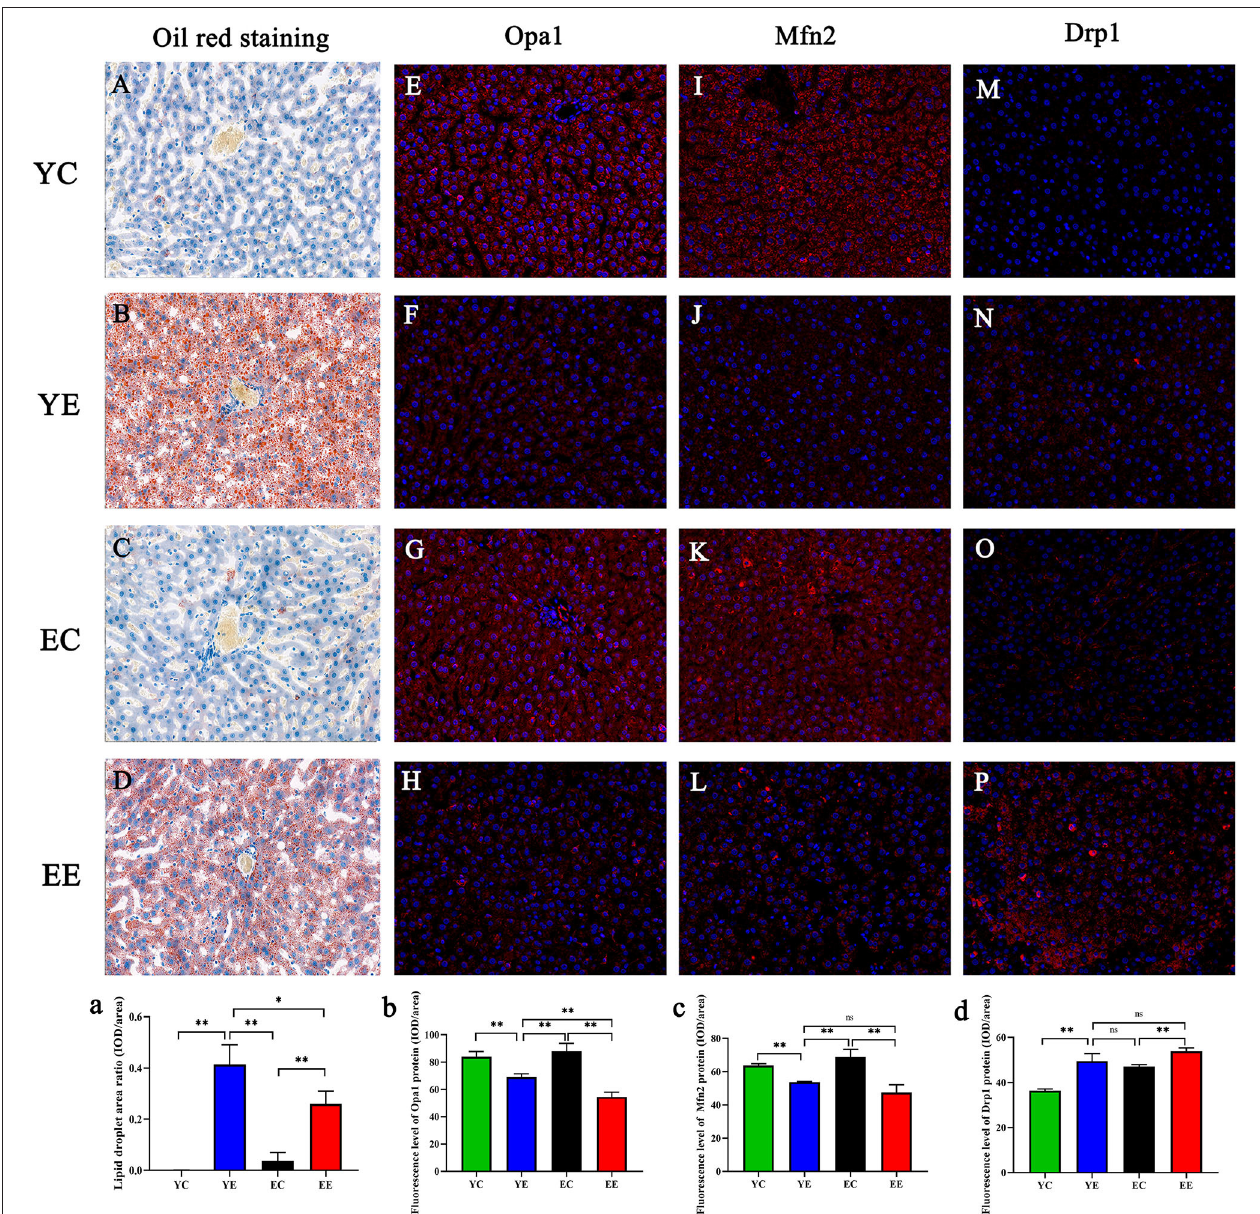
FIGURE 5 | (A–D) Oil Red O staining of the liver. Original magnification: × 200. Opa1 (E–H) , Mfn2 (I–L) , and Drp1 (M–P) in liver mitochondria were labeled with red fluorescence in the cytoplasm and blue fluorescence in the nucleus. Effect of diet on hepatocytes of mice in each group. (a) Data analysis of liver lipid droplet area observed by Oil Red O staining. Opa1(b), Mfn2 (c), and Drp1 (d) protein fluorescence assay. * p < 0.05, ** p < 0.01, ns p >